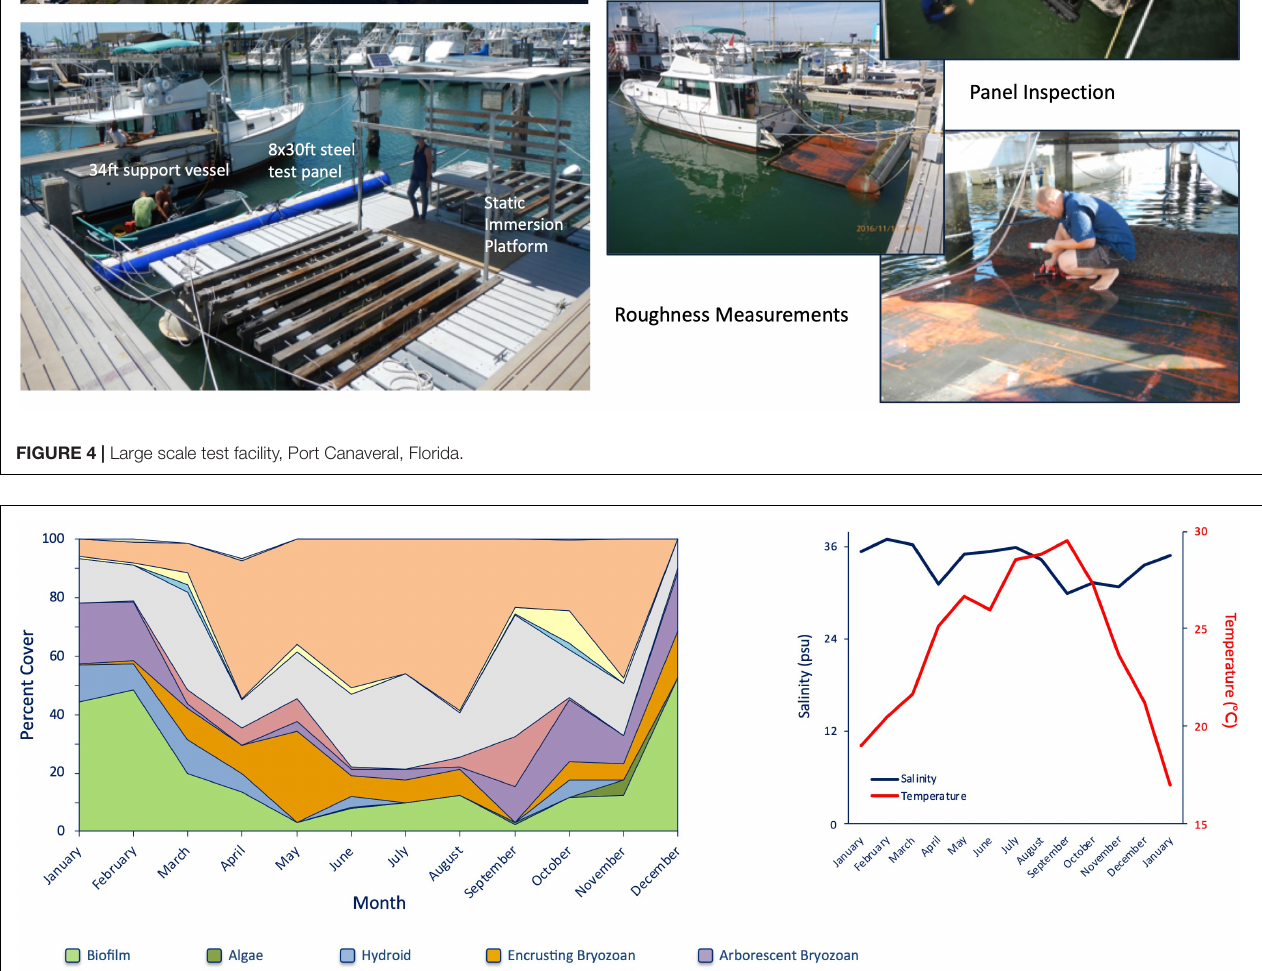
as a control center for the grooming vehicle and was moored adjacent to the pipe. The fouling control surfaces were groomed on a weekly basis and ungroomed areas acted as controls. The panels were inspected by divers and periodically, the panels were rotated to the horizontal position to enable visual inspection, dry film thickness and roughness